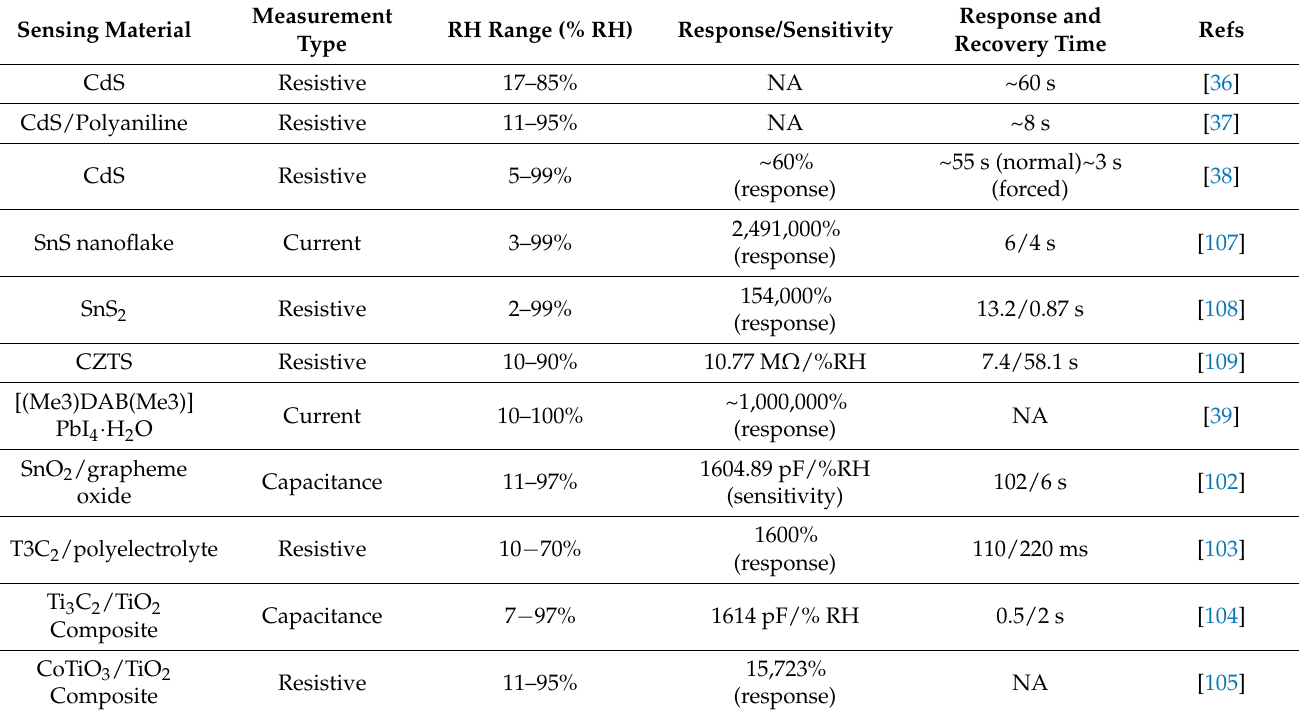
Table 5. The semiconductor humidity-nanosensor